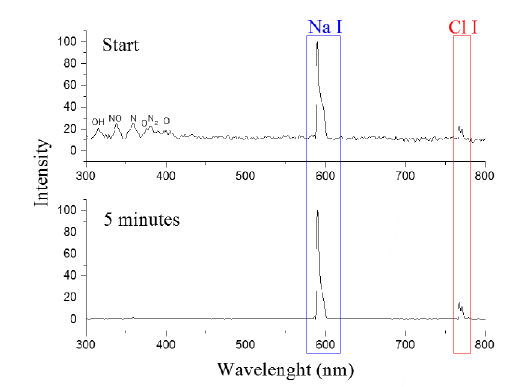
Figure 3. Crystals forming under the electric discharge effect. Figure 4. Optic Emission Spectroscopy from the discharge zone, in the beginning of the discharge ad after 5 minutes.